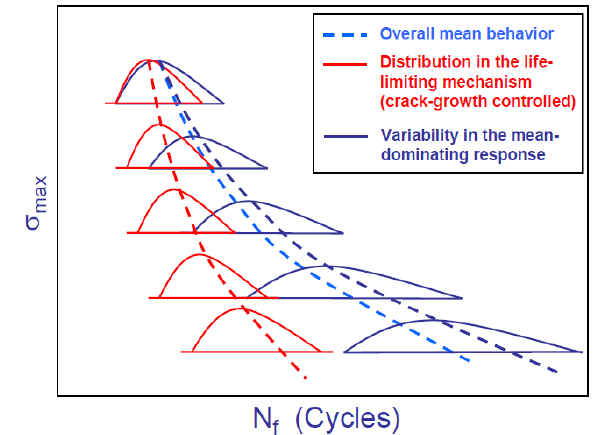
Figure 16. Illustration of the proposed description of fatigue variability behavior with respect to stress level [37].